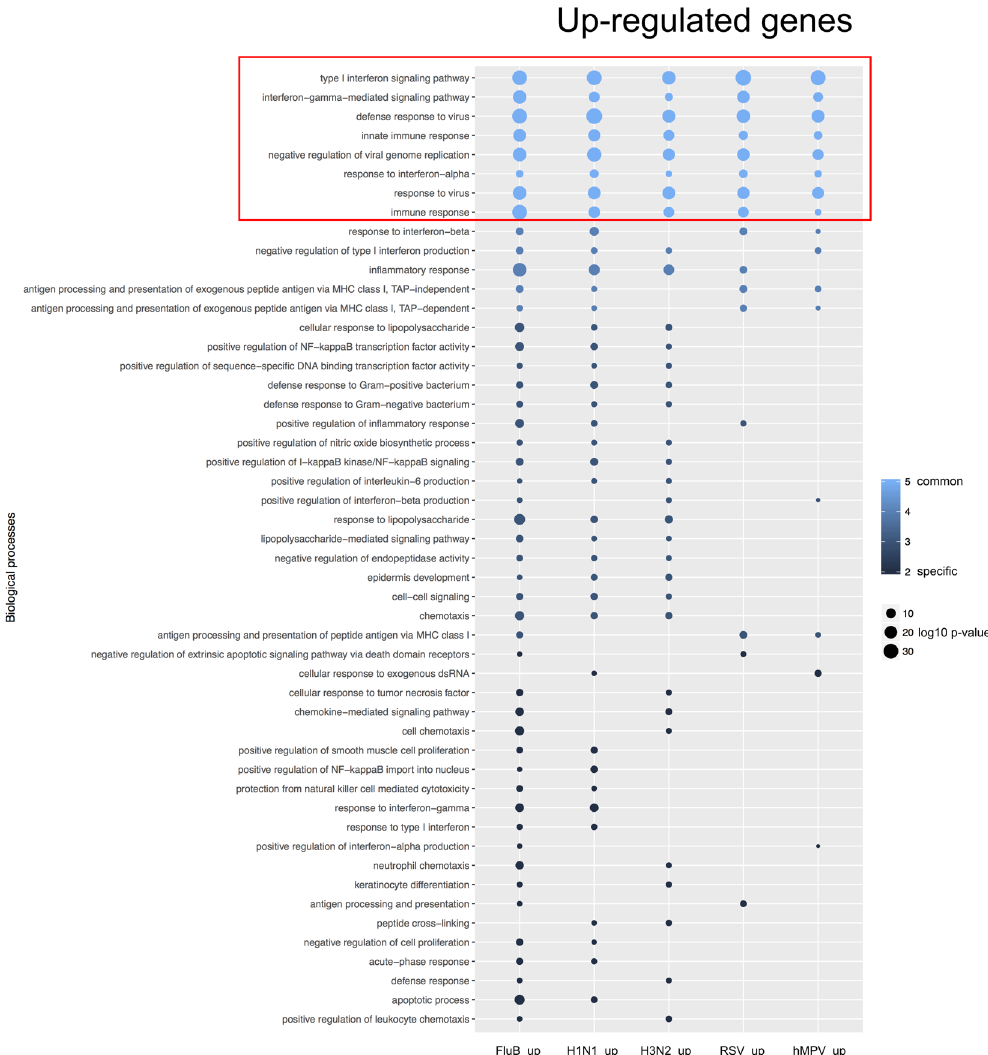
Figure 5. Up regulated genes mainly account for interferon/immune responses in viral-infected HAE. Enrichment was performed on each gene list (up-regulated genes) and biological processes enriched in a least one infection with a Benjamini corrected p-value inferior to 0.01 were plotted. The log10-transformed (Benjamini corrected enrichment p-value) is color-coded in a gradient from dark blue (specific to one infection) to pale blue (common between all five infections). Dot size is proportional to p-value. The absence of dot in a column signifies the absence of enrichment of this specific biological process with the defined thresholds. The only biological processes enriched in every infectious condition immune response related terms (type I interferon signaling pathway, response to virus, (defense) response to interferon-alpha, negative regulation of viral genome replication, interferon-gamma-mediated signaling